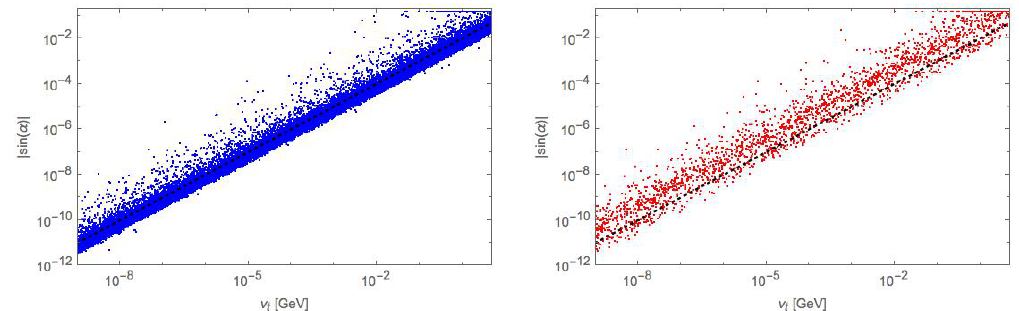
Figure 2 . The viable parameter space in the sin (cid:11) vs v t plane. In the left (cid:12)gure sin (cid:11) is positive while in the right (cid:12)gure it is negative. In both cases, there is a clear correlation between the two parameters. On the dotted line j sin (cid:11) j = 2 : 46 v t =v . m (cid:0) (cid:1) m plane inconsistent with the S and T parameters at 95% CL. This is shown as H ++ a shaded region in (cid:12)gure